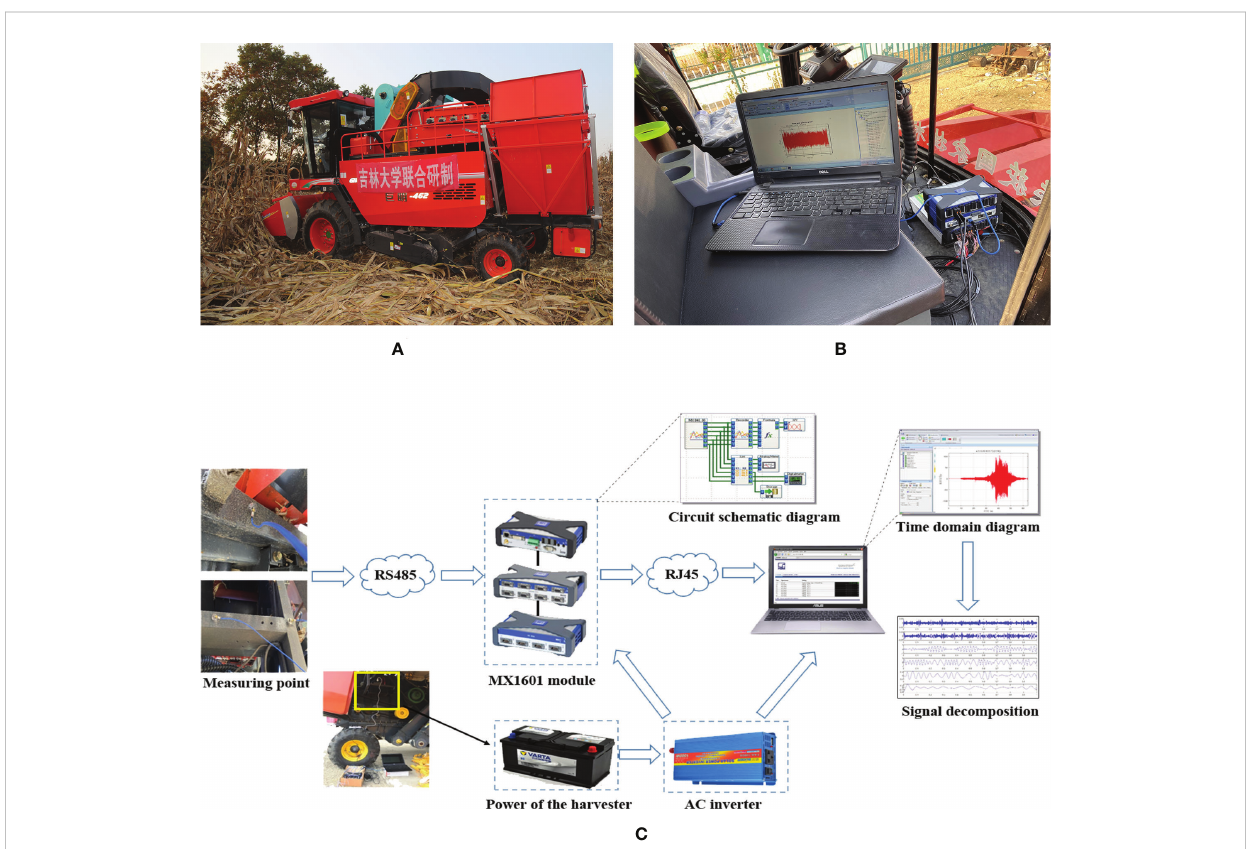
FIGURE 1 Experimental machine and wiring diagram: (A) Experimental corn harvester; (B) Test system wiring diagram; (C) Test system schematic